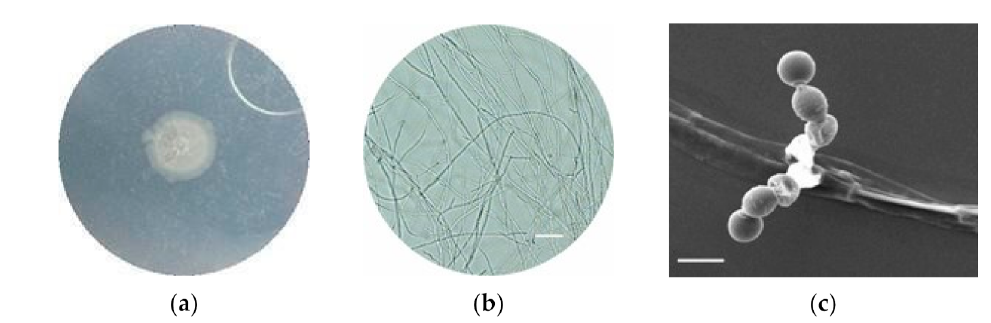
Figure 3. ( a ). Isolate 18A13O1 in colloidal chitin media, ( b ) visualization 18A13O1, bar 40 micron with light microscope scale 200 × , ( c ) SEM image aerial hyphae isolate 18A13O1, bar 4